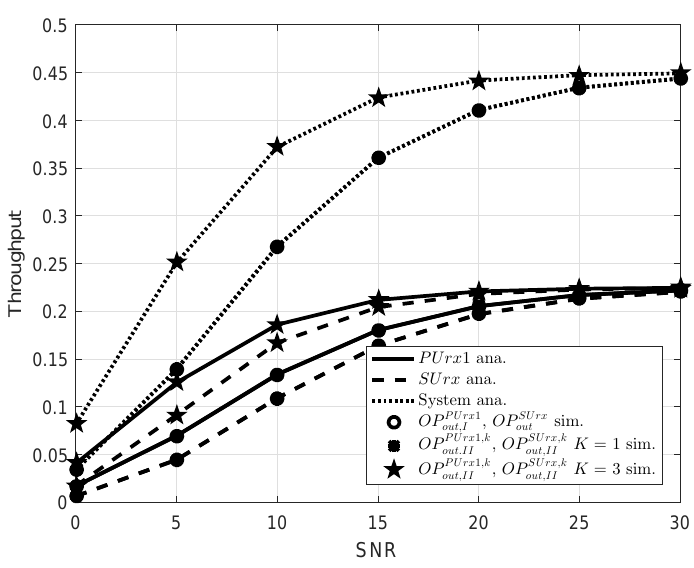
Figure 11. Scheme 2: Throughput performance of Schemes 1 and 2 versus SNR ( K = 1,3 for Scheme